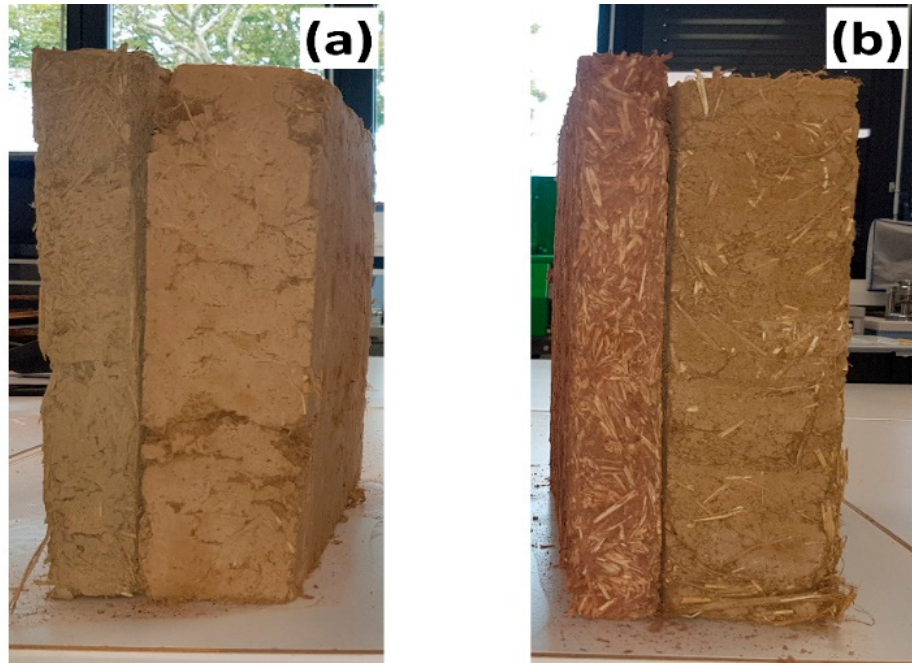
Figure 10. Cob walls with two layers: ( a ) GWM-FA-CR mixture and ( b ) usual cob.